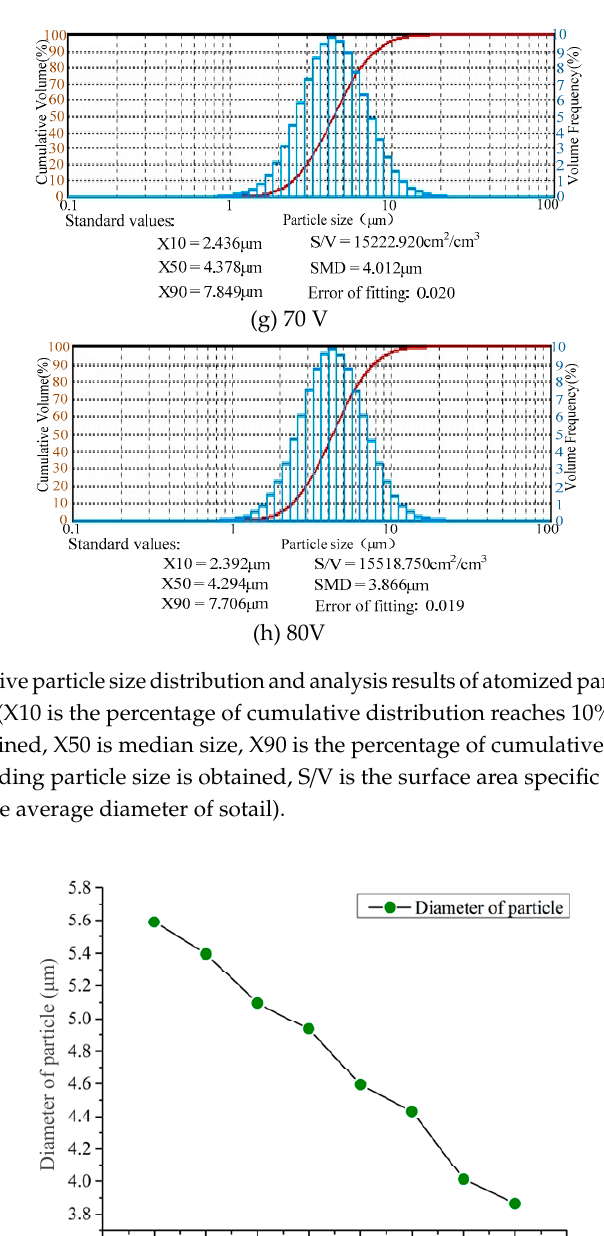
Table 1. Measurement results of the micro-cone hole under different voltages. (d1 is the small diameter of the cone hole, d2 is the large diameter of the cone hole, t is the thickness of the dispenser. ).